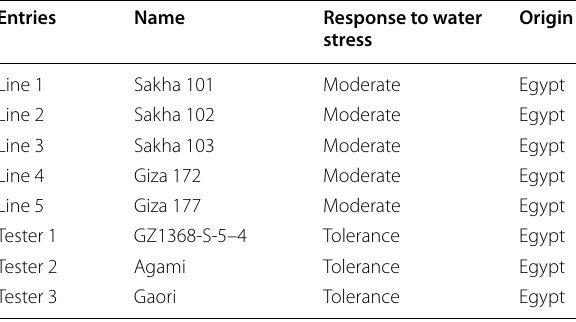
Table 1 Various reactions for drought tolerance in the eight